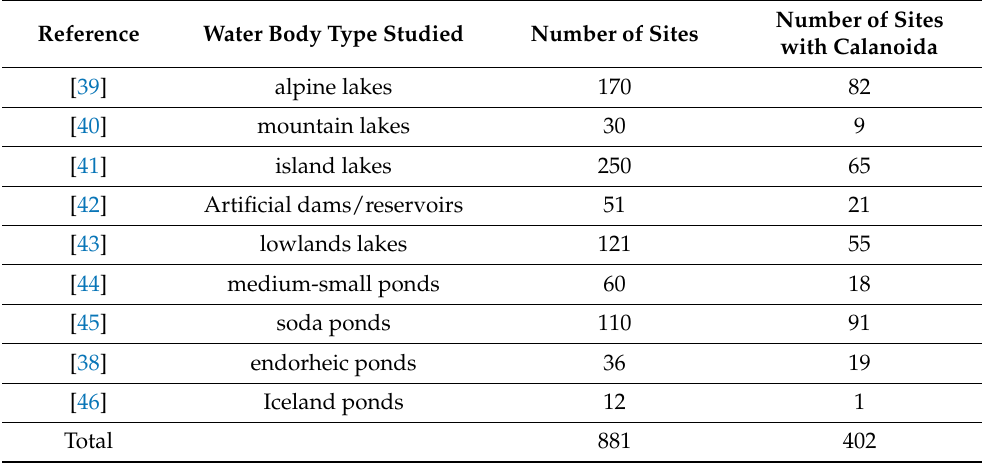
Table 2. The presence of Calanoida in freshwater bodies of different types and origins. In the same water bodies, Cyclopoida (not reported here) are present in more than 95% of sites.